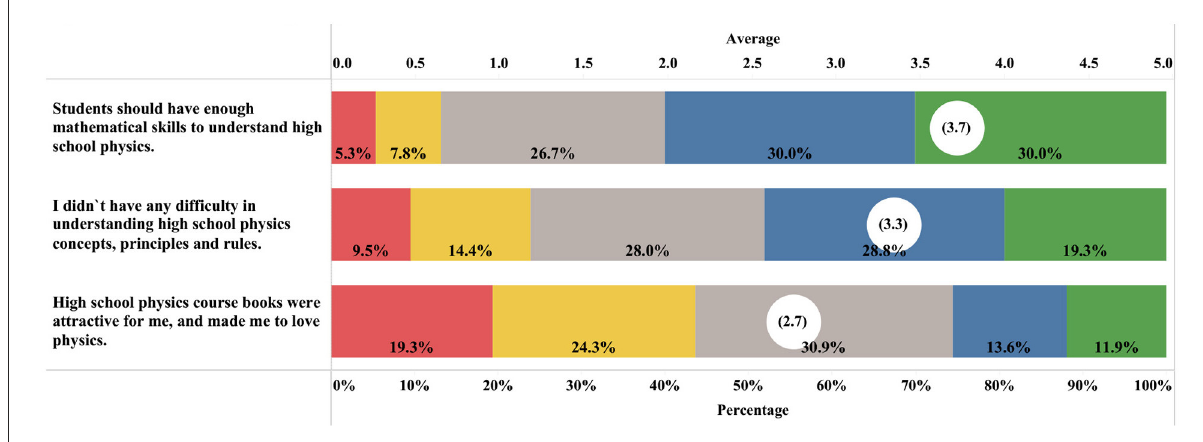
FIGURE4 Distribution of students’ opinions on learning physics and agreed level.